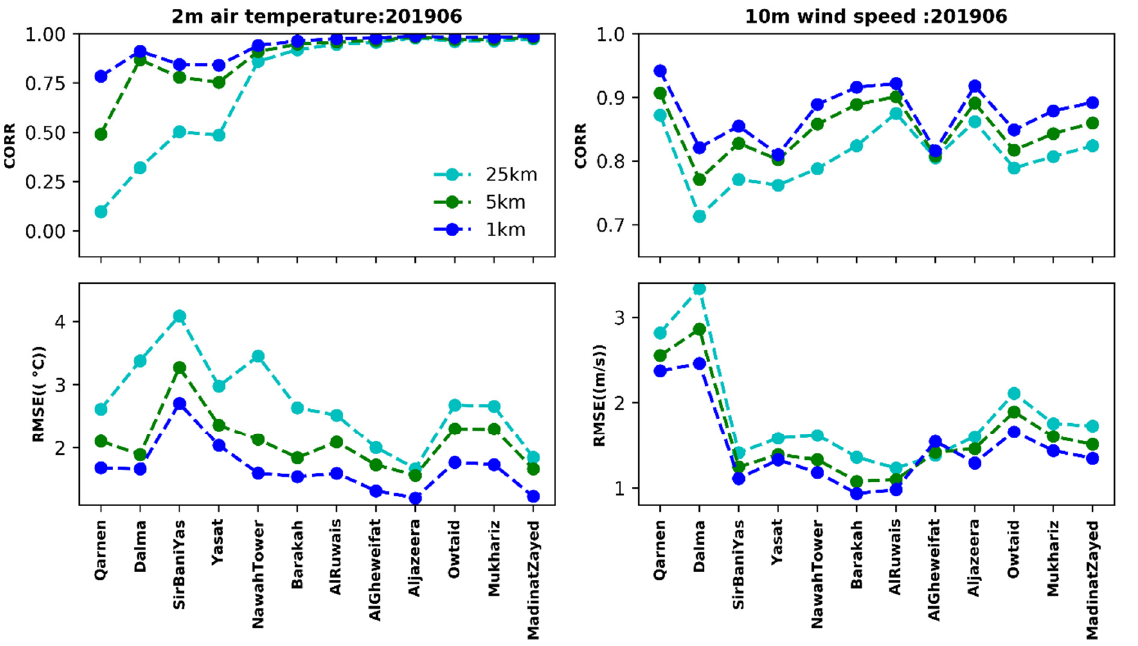
Figure 6. Impact of horizontal resolution on model performance. Panels show the correlation and RMSE between the model and the 12 stations. Statistics are calculated for T2 and WS using June 2019 data of the experiment EXP08 at spatial resolutions of 1 km, 5 km, and 25 km.